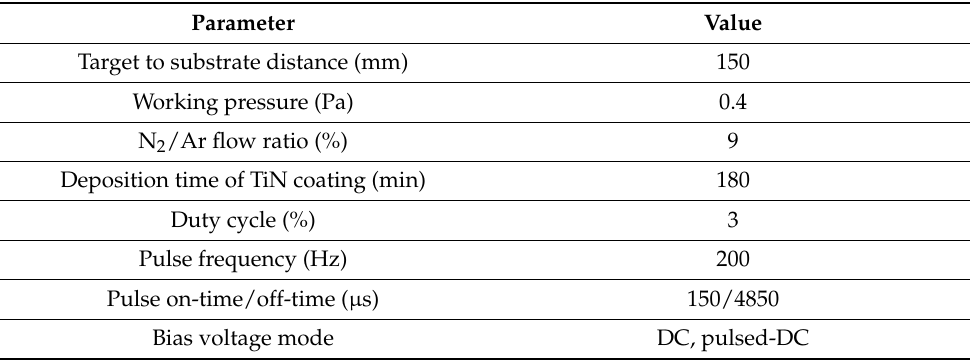
Figure 1. Schematic drawing of the HiPIMS system. Table 1. HiPIMS parameters used in deposition of TiN coatings.